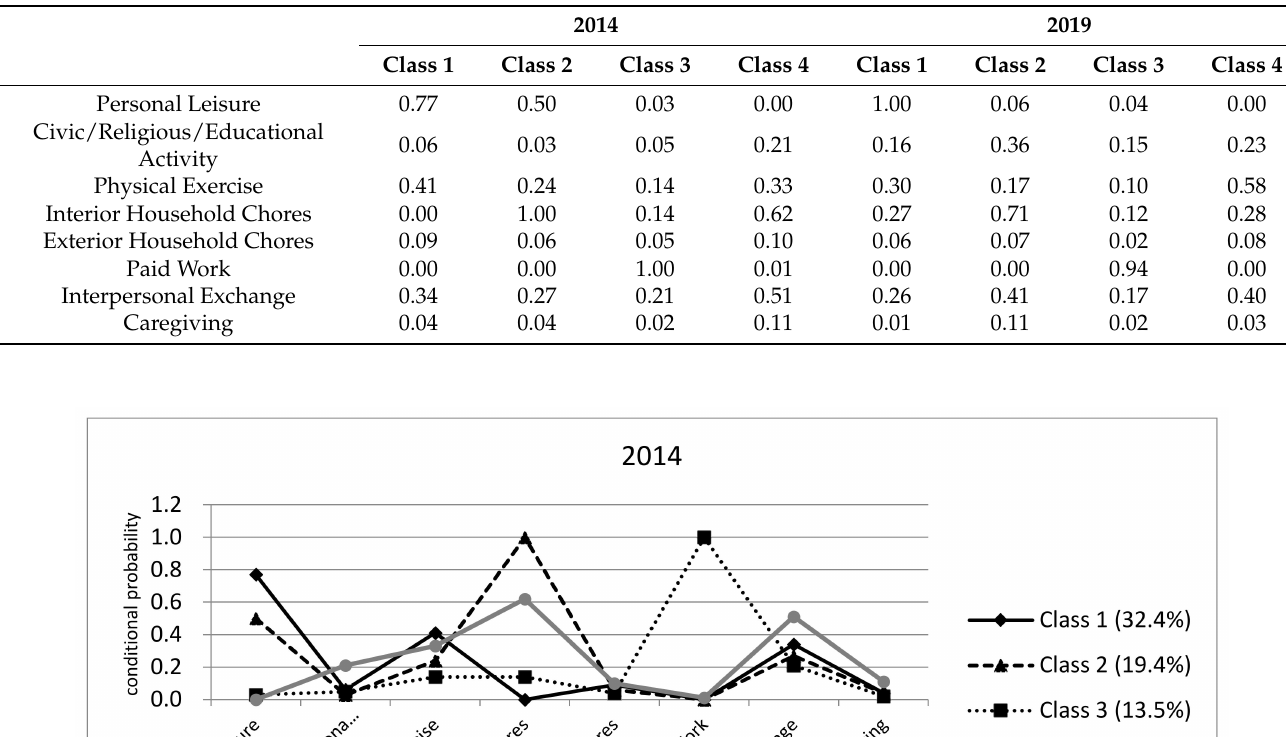
Table 3. Conditional probabilities of being in “high” activity engagement.